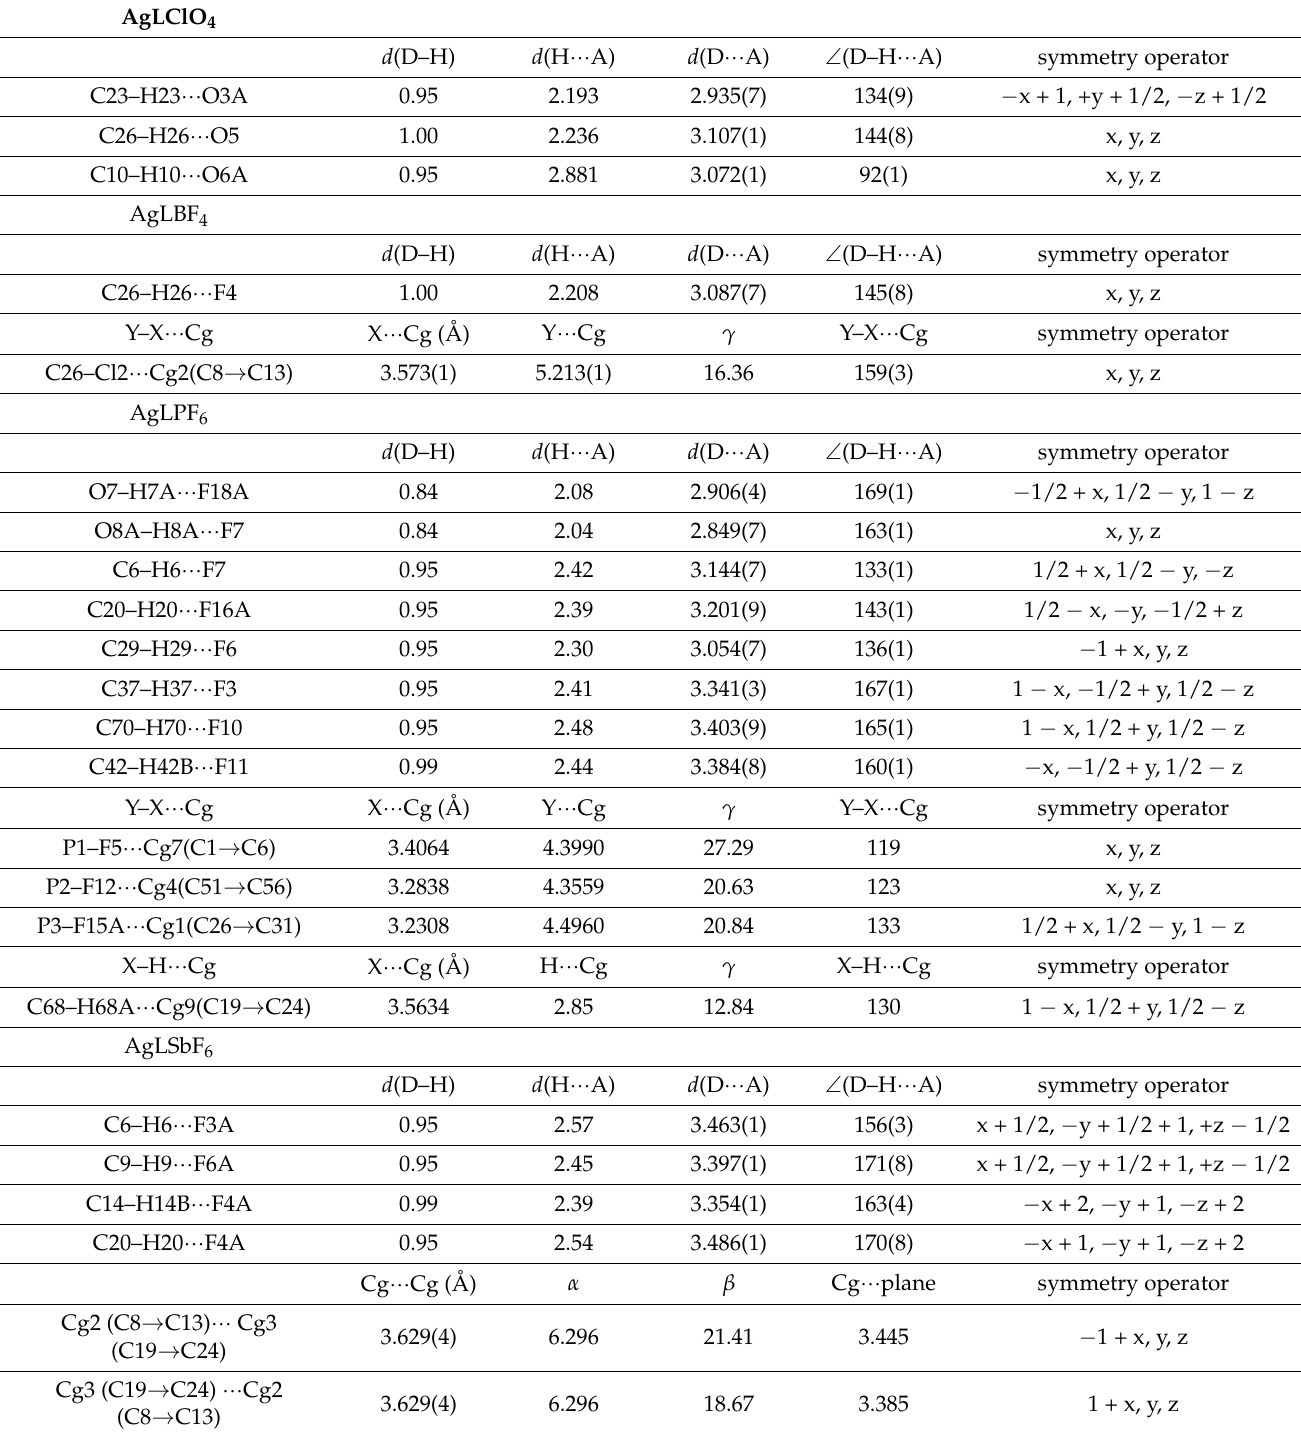
Table 2. The details on hydrogen bond geometry for AgLClO 4 , AgLBF 4 , AgLPF 6 , and AgLSbF 6